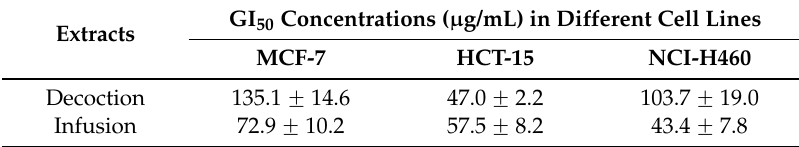
Table 1. GI 50 concentrations of T. lignosa extracts in three human tumor cell